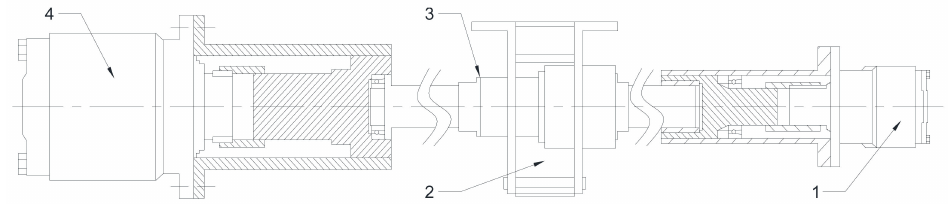
Figure 9. Double regulating mechanism structure of speed and opening. 1: Speed hydraulic motor; 2: Fertilizer discharge box; 3: Fertilizer discharge stop shaft; 4: Opening hydraulic motor.